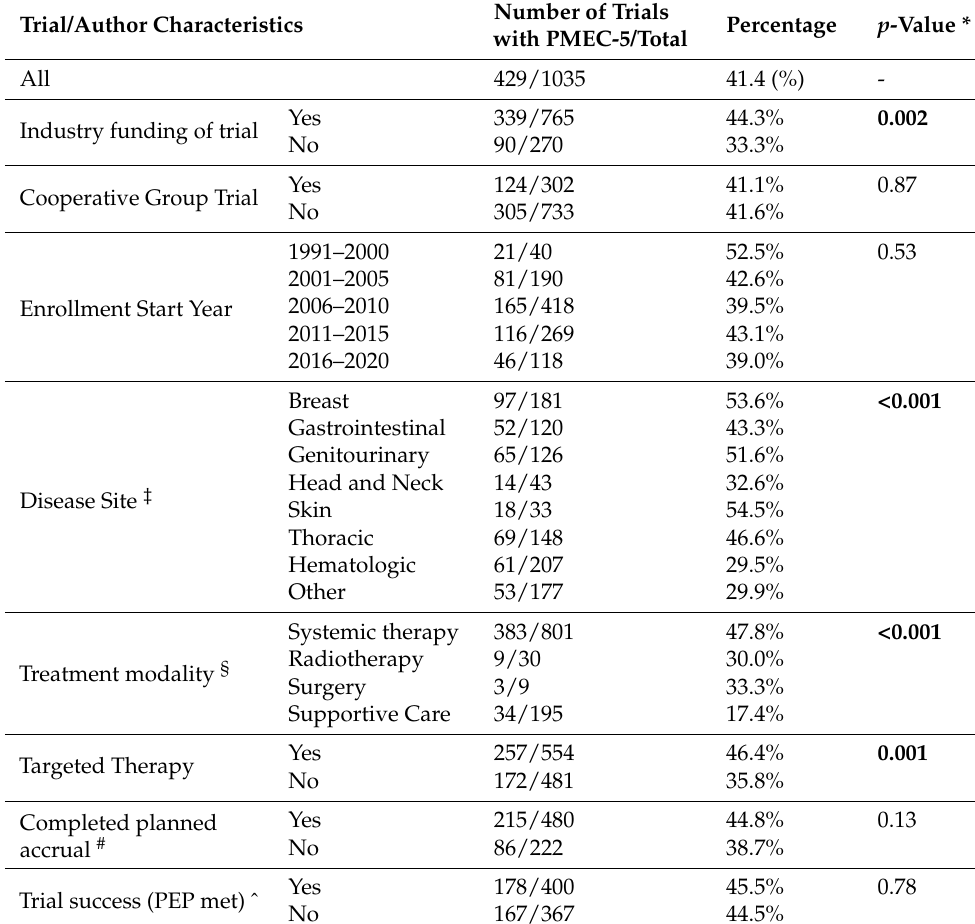
Table 1. Factors associated with PMEC-5.